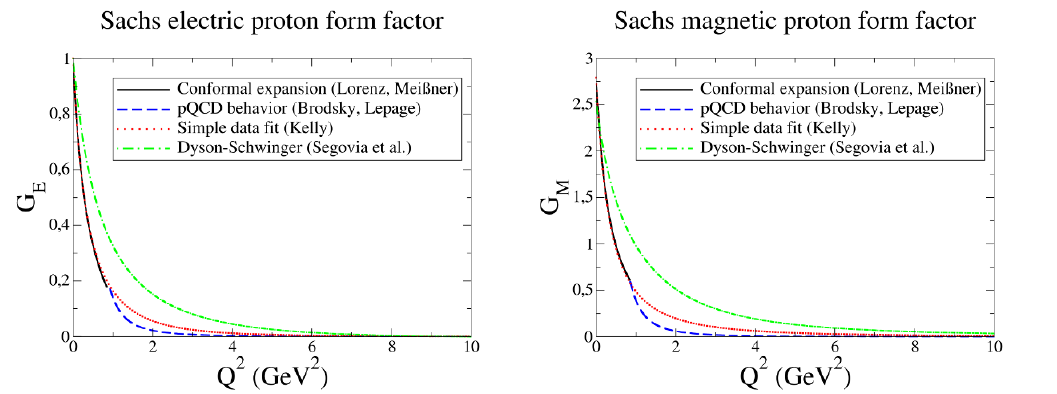
Figure 5 . Some form factor parametrizations and theoretical computations as functions of Q 2 taken from the ample literature. Solid and dashed line: matching eq. (4.9) at low momentum transfer with the Brodsky-Lepage asymptotic form. Additionally, simple (cid:12)t to the data by Kelly (dotted line) and Dyson-Schwinger computation by Segovia and others (dotted-dashed